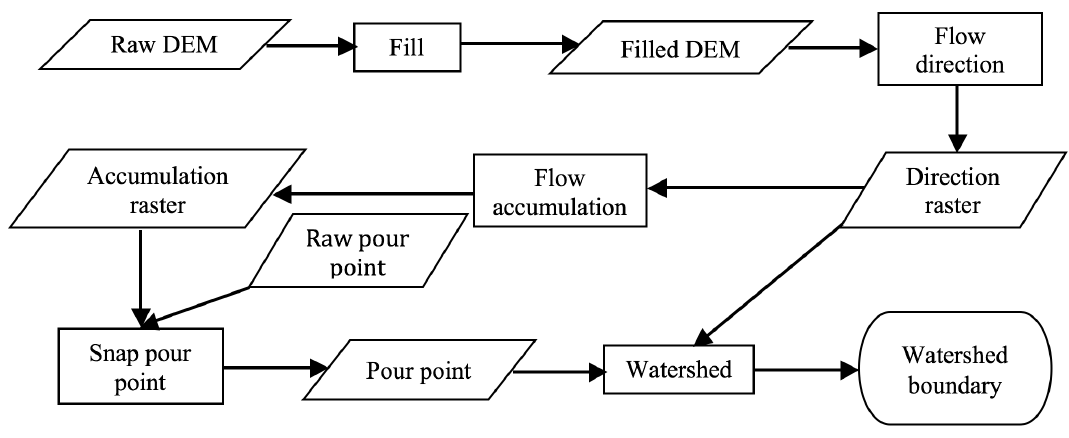
Figure 2. Urban watershed delineation in